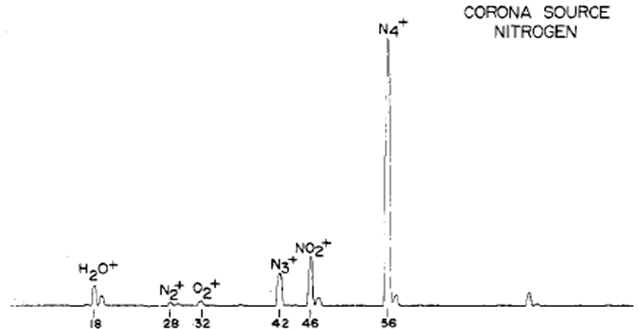
Figure 4. Mass spectrum of nitrogen obtained with a corona discharge point located at a distance of 0.5 mm from the sampling aperture. Figure adapted from [35] with permission. Copyright 1976 American Chemical Society.